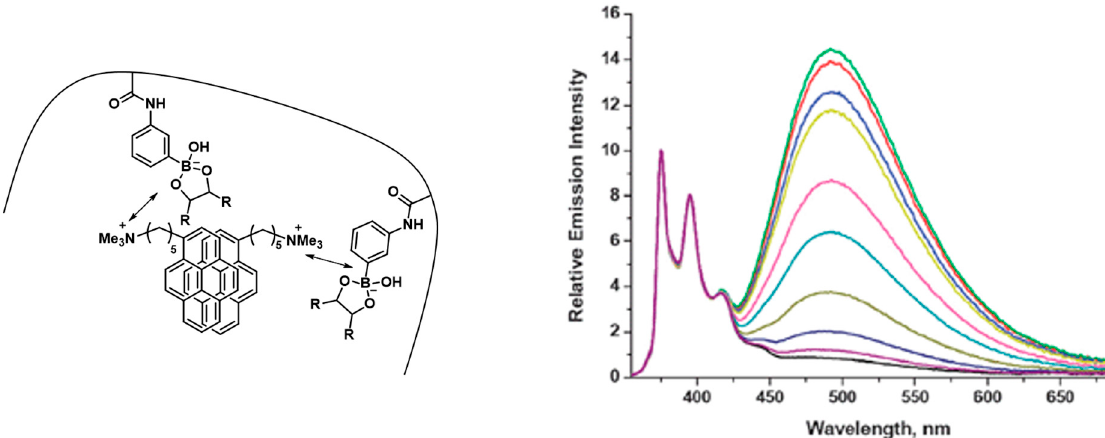
Figure 10. ( Left ) Schematic representation of electrostatically induced excimer formation of positively charged trimethylpentylammonium pyrene salt. ( Right ) Emission spectra (normalized at 375 nm) with increased glucose concentration showing excimer emission enhancement between 450 nm and 650 nm [93]. Reproduced by permission of The Royal Society of Chemistry.